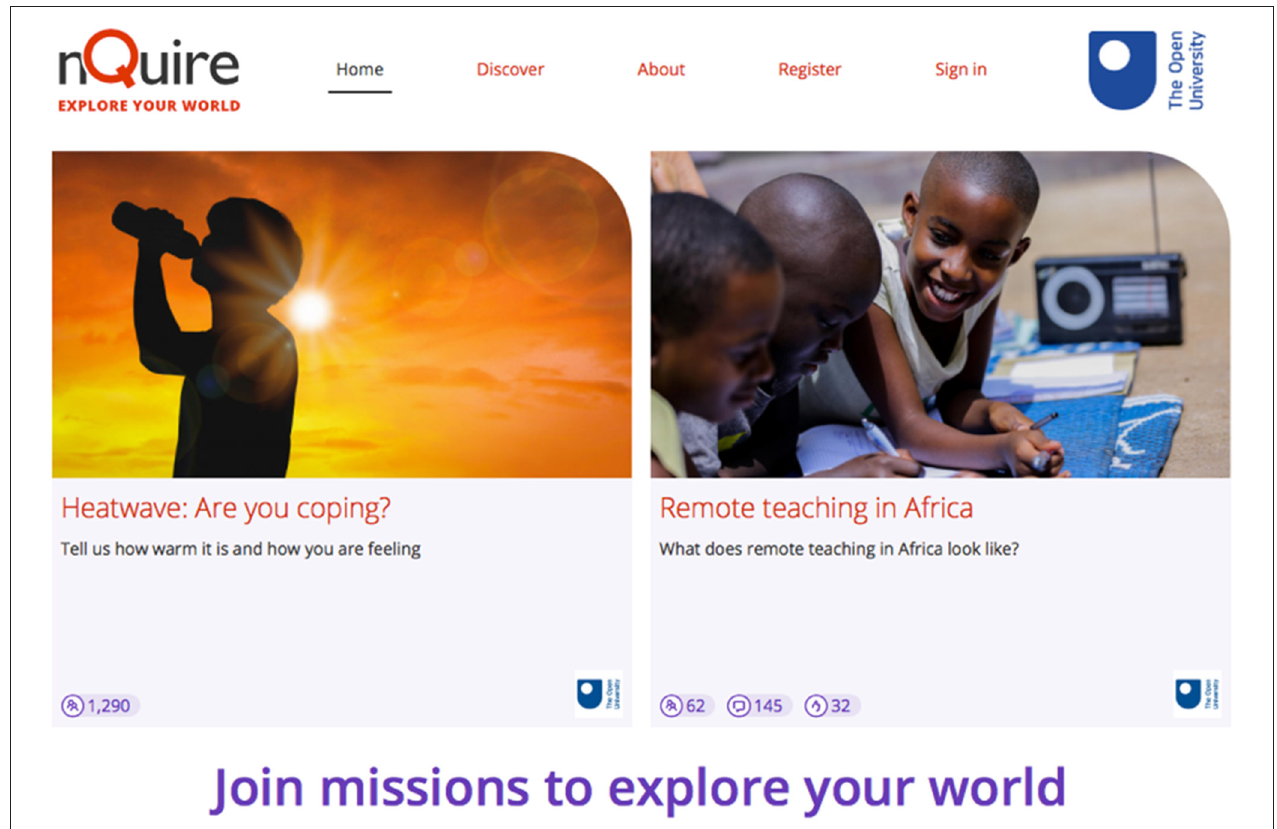
FIGURE 1 | A confidential and a social CS investigation on